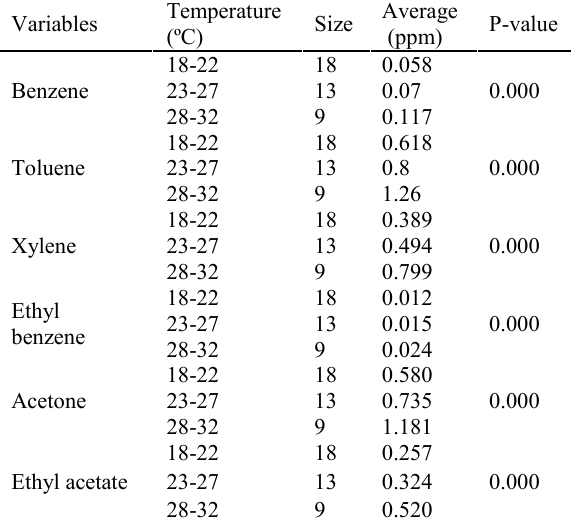
Table 7. The effect of temperature during measurement on volatile organic compound concentration